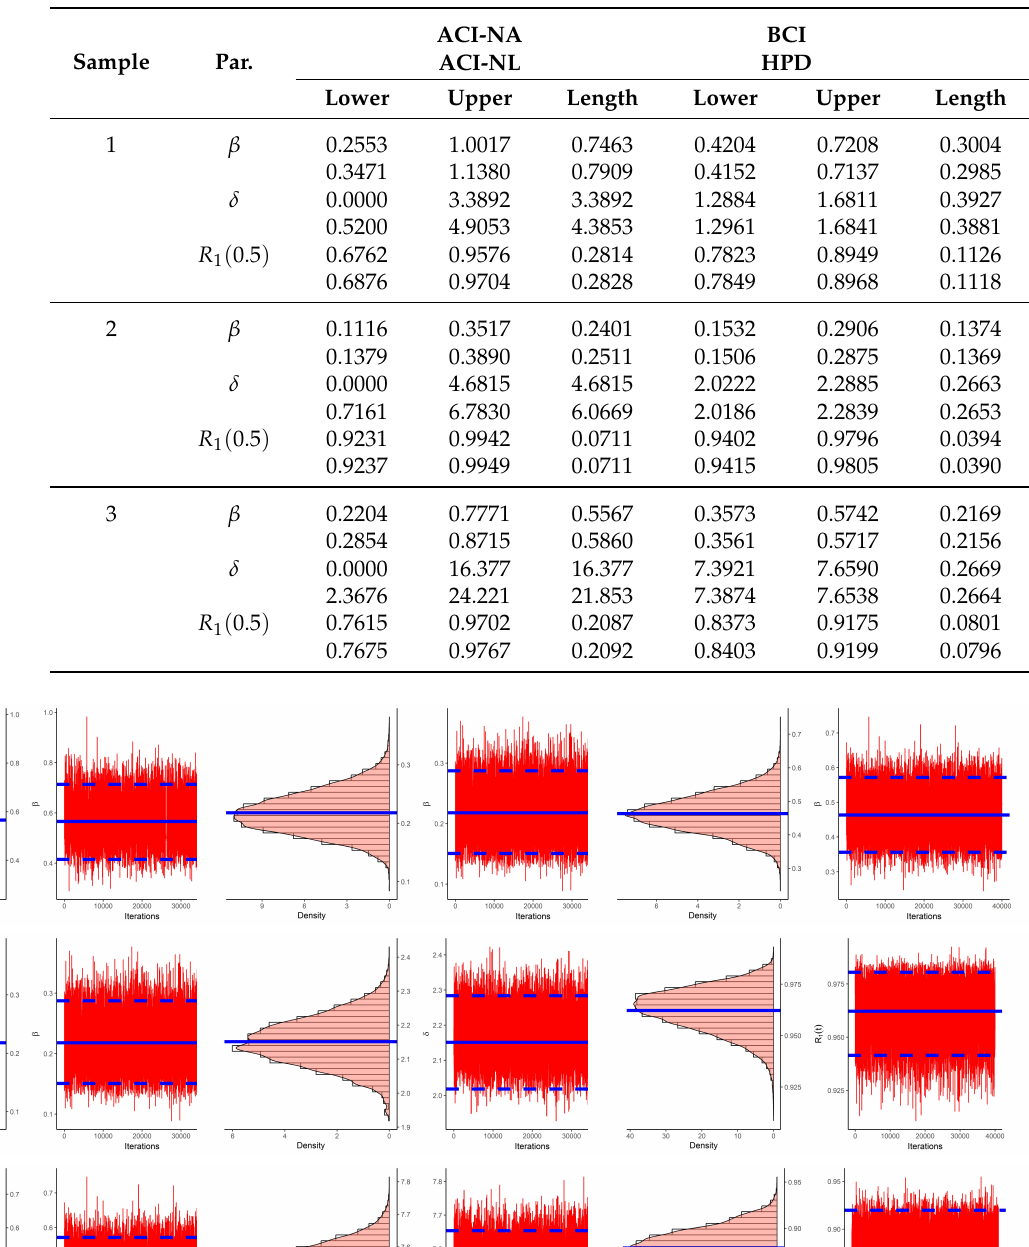
Table 5. Interval estimates of β , δ and R 1 ( t ) from insulating fluid data.